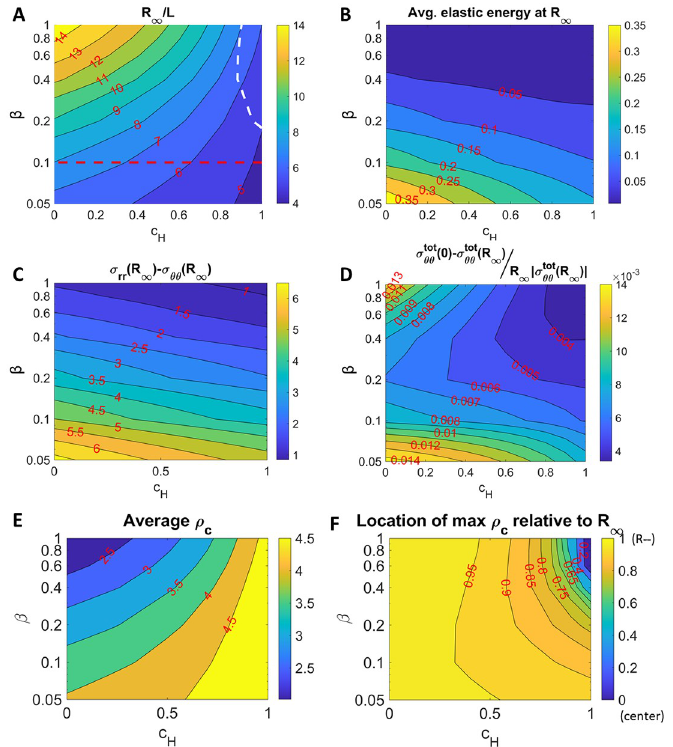
Fig 5. Contour plot of steady-state tumor radius (A), average elastic energy in the tumor at steady-state (B), stress anisotropy at tumor boundary (C), averaged stress gradient in the tumor, (D), steady-state average density (E), and location of maximum ρ relative to tumor boundary (F) as a function of β and c c the s tot ð 0 Þ ¼ 0 contour. The dashed red line shows the region where the dynamics of the radius are non-monotone yy (see Fig A in S5 Text). In (F), a value of 1 corresponds to the tumor boundary, while a value of 0 corresponds to the tumor center. See the main text for more